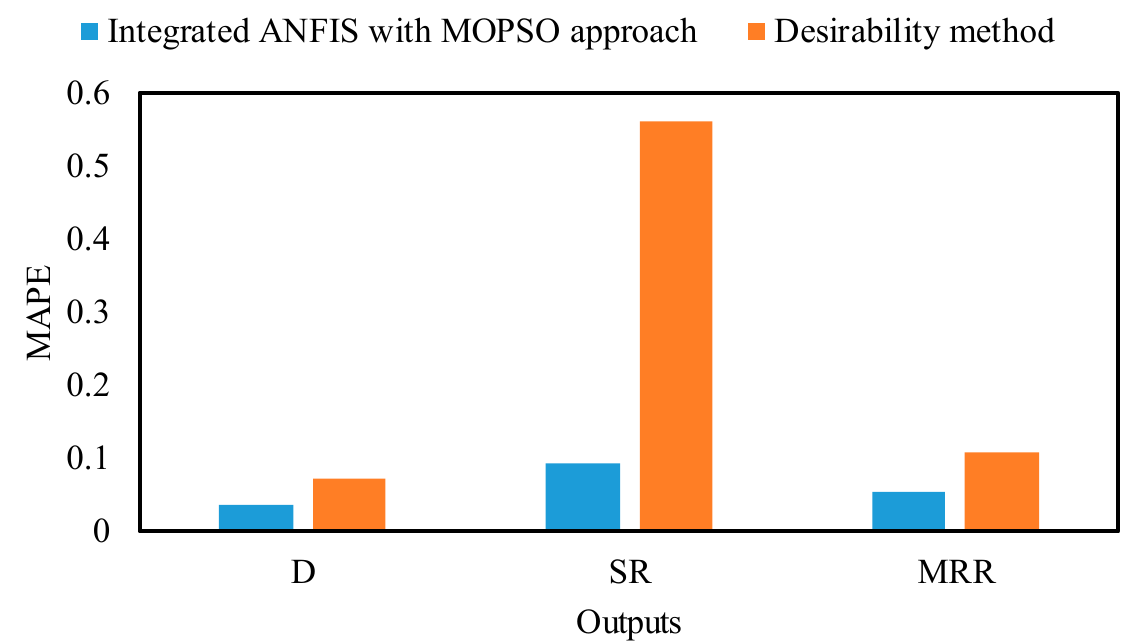
Figure 15. Evaluation of ANFIS–MOPSO and desirability method experiments using MAPE.